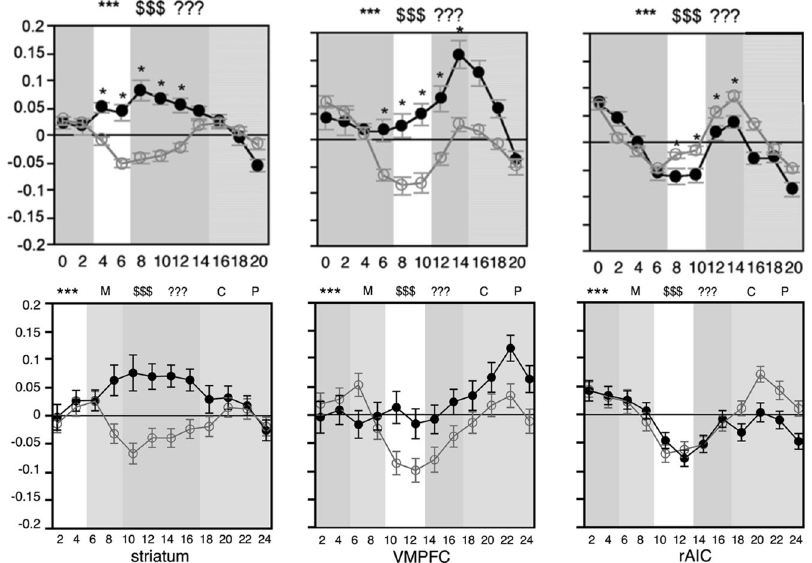
Figure 2. Comparison with Knutson et al. 21 . Neural activation time courses in the striatum, VMPFC, and rAIC distinguishing purchase (black) from non-purchase (grey), y-axis labeled with percent signal change. Above: Fig. 2 from Knutson et al. 21 . Below: time courses from the current study collapsed across payment methods. Phases: * = product, M = method, $ = price, ? = choice, C = confirm, P =